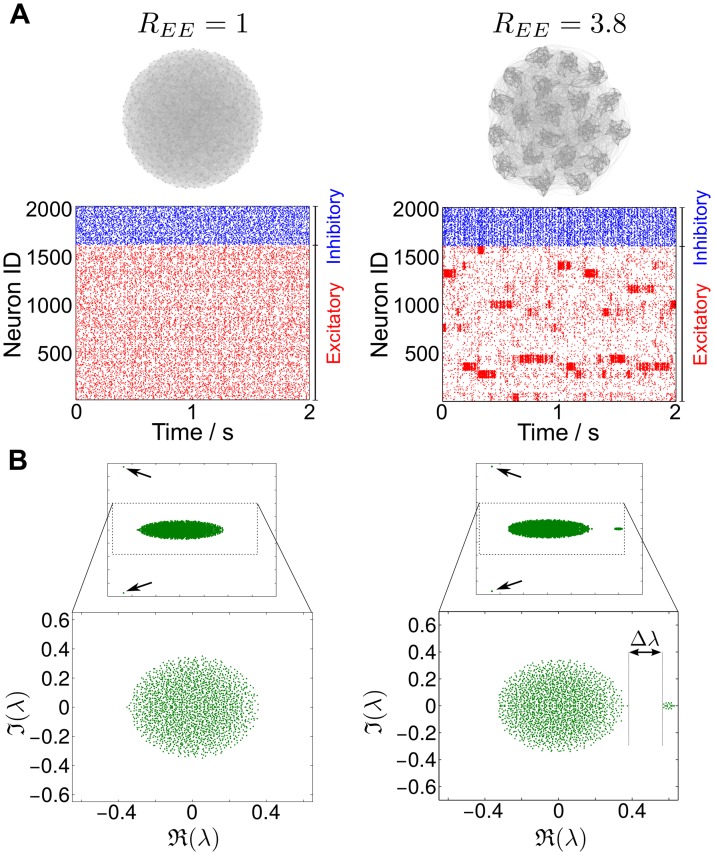
Network dynamics and eigenvalue spectra of two LIF networks.One network with uniform synaptic connections (left), and one with 20 groups of clustered excitatory connections (right). To create the clustered network, excitatory neurons were partitioned into groups (with in-group connection probability pinEE and out-group connection probability poutEE<pinEE) while keeping the average connectivity constant (see Materials and Methods and Ref. [22]). The ratio REE=pinEE/poutEE controls the strength of the excitatory clustering. A Visualization of the network topologies (top) and exemplars of raster plots (bottom). The dynamics of the clustered network exhibit the banded structure associated with slow-switching group activity. The magnitude of this switching can be characterized statistically a posteriori from the data through the spike-rate variability metric S^, defined in Materials and Methods Eq (18), as discussed in the text. In this case, the unclustered network has S^=0.035 while the clustered network has a much larger value S^=8.23. B Eigenvalue spectra of the network weight matrices W. The weighted connectivity matrix of the clustered network exhibits a clear eigengap Δλ separating the 19 eigenvalues with largest real parts from the cloud of eigenvalues in the bulk. There is no such eigengap for the unclustered network. As indicated by the two arrows, both matrices have a pair of complex conjugate eigenvalues associated with the (damped) global activation modes of the networks characteristic of balanced networks (see text and Ref. [29]).